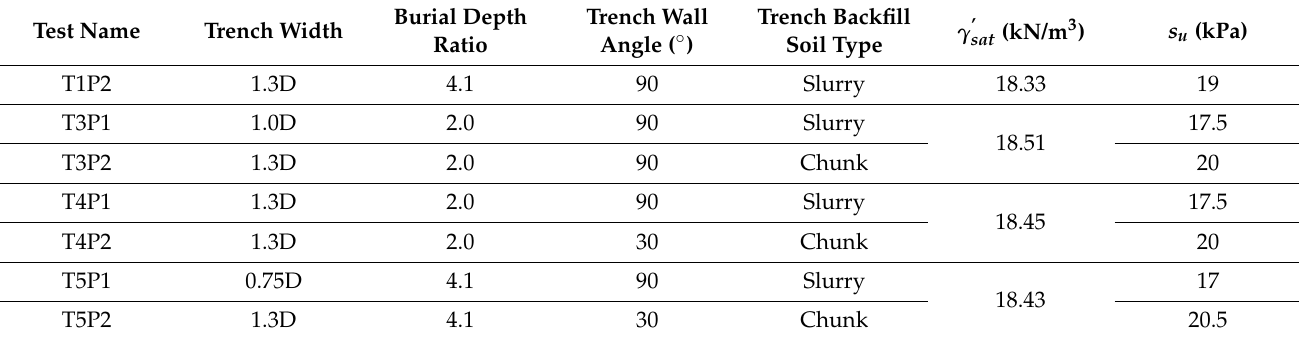
Table 1. Summary of experimental studies in clay [24].